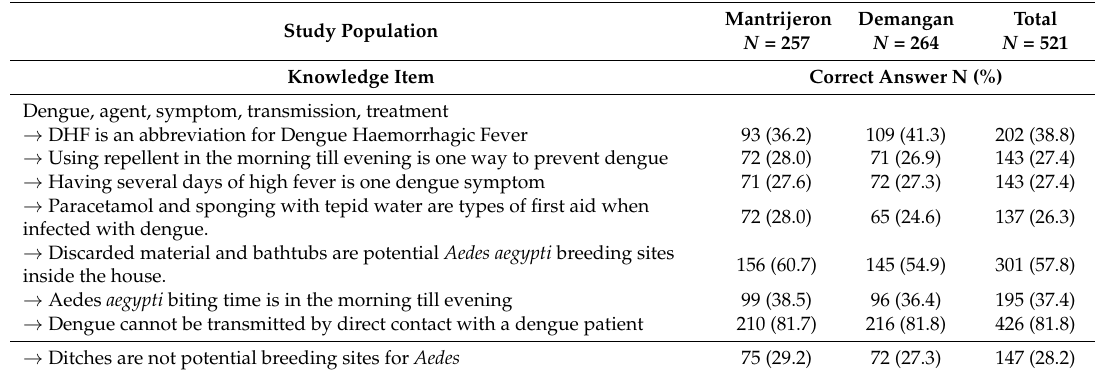
Table 2. Knowledge regarding dengue agent, symptom, transmission and